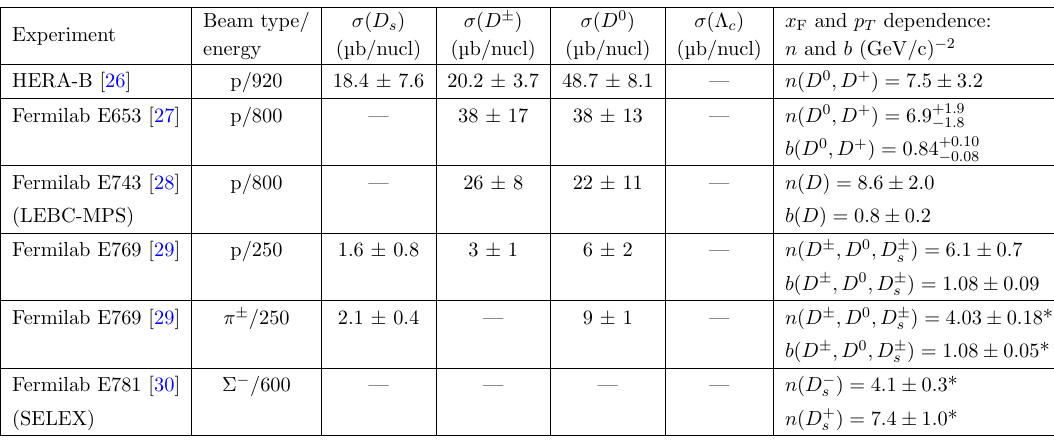
Table 4 . Charmed particle di(cid:11)erential production cross section results obtained by the (cid:12)xed-target experiments. *: incident particle is not